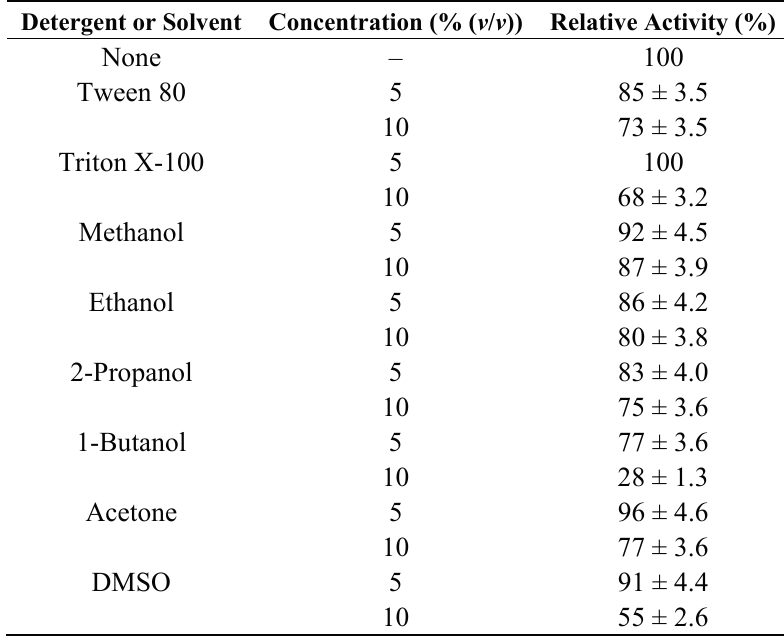
Table 4. Effect of detergents and solvents on the HydS14